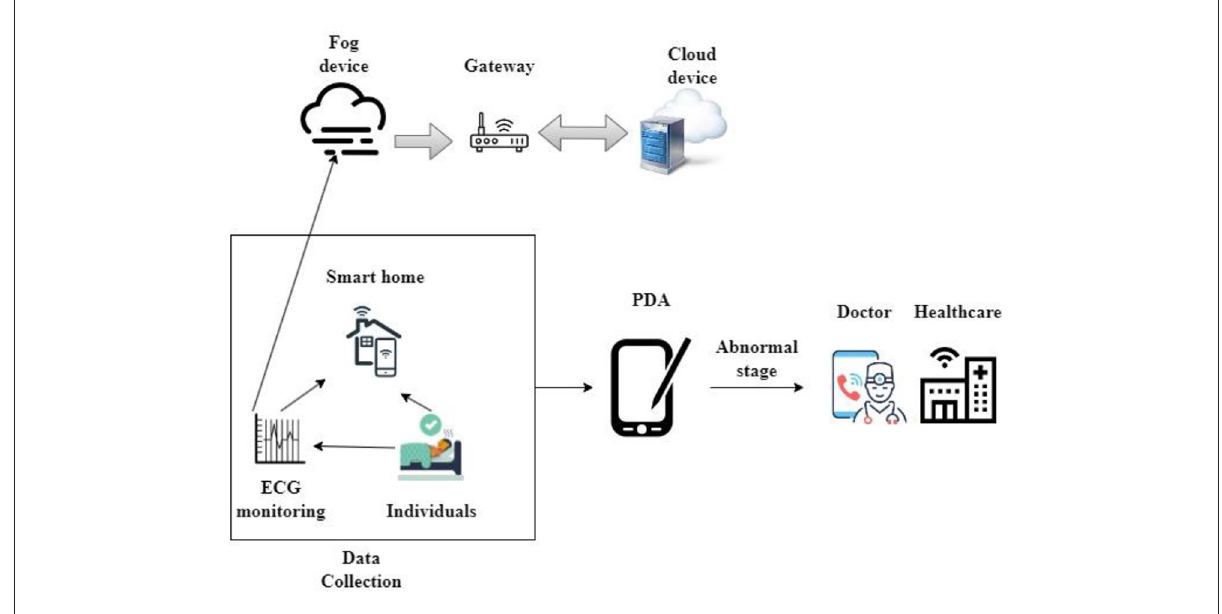
FIGURE3 Data collected from smart home environment.